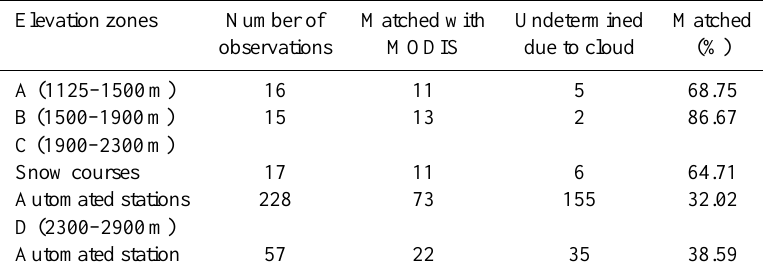
Table 1. Summary of analysis for MODIS images performed in winter 2002–2003 (December–March) at snow courses and automated stations with respect to elevation zones.